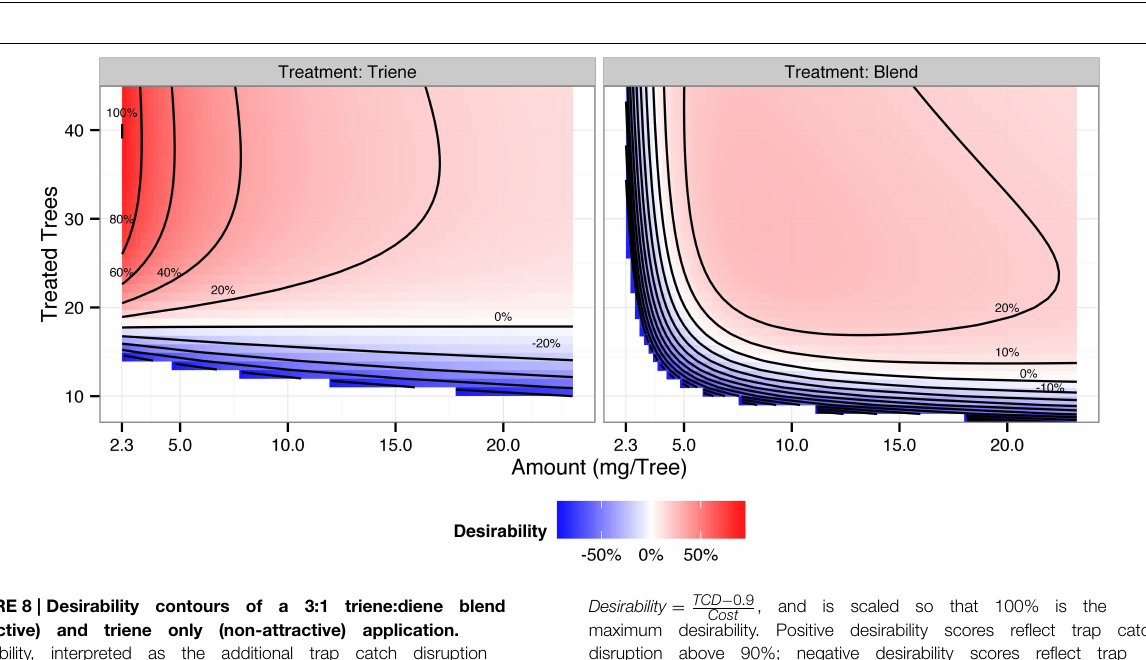
FIGURE 8 | Desirability contours of a 3:1 triene:diene blend (attractive) and triene only (non-attractive) application. Desirability, interpreted as the additional trap catch disruption obtained per unit cost, is calculated according to